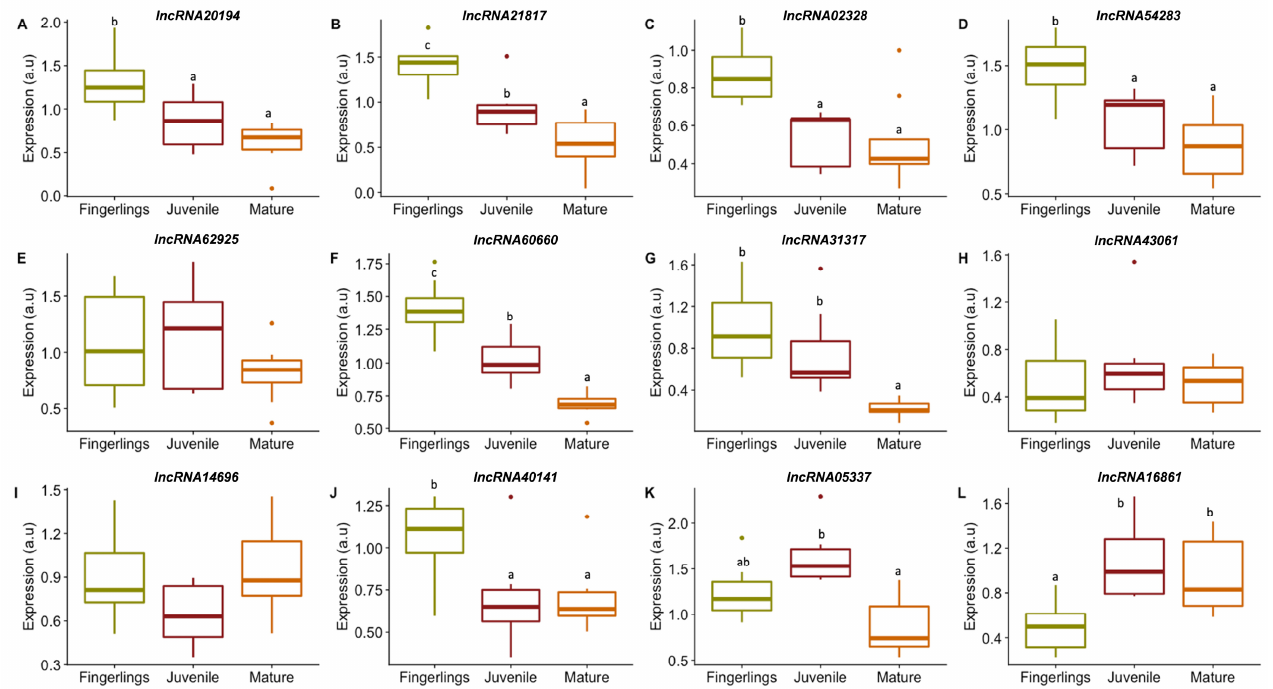
Figure 3. Expression of selected lncRNAs in gilthead sea bream fast skeletal muscle at different ontogenetic stages. Boxplots showing lncRNAs expression in gilthead fast skeletal muscle obtained from fingerlings (green box), juveniles (dark red box) or adults (orange box) ( A – L ). Gene expression is indicated as arbitrary units (a.u). Significant differences between ontogenetic stages are indicated as different letters when p < 0.05. Outliers are presented as